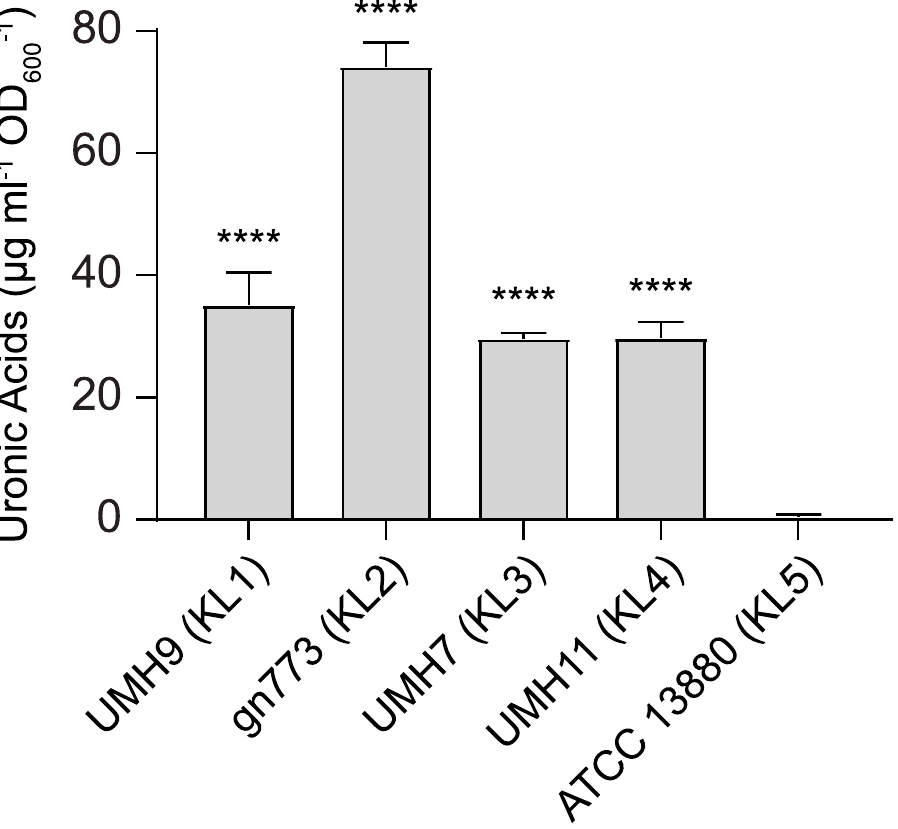
Fig 6. Acidic CPS production by S . marcescens strains isolated from BSI. Total cell-associated uronic acids from S . marcescens strains cultured in M9 medium supplemented with glucose were quantified by colorimetric assay. Uronic acid levels were normalized to culture density and calculated based on a glucuronic acid standard curve. Significant differences relative to the acapsular strain ATCC 13880 were assessed by one-way ANOVA with Dunnett’s multiple comparisons test ( ���� , P < 0.0001).